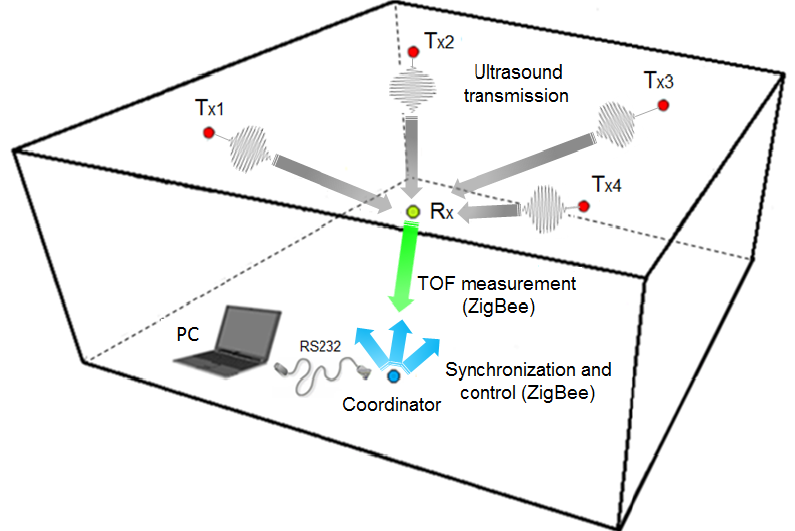
Figure 4. The typical configuration of the TELIAMADE system. A coordinator node is connected to a PC through which all other nodes of the network are managed. A set of fixed nodes work as ultrasonic transmitters (Tx) and are placed on known positions (typically at the ceiling). The mobile node operates as ultrasonic receiver. Its position is determined by applying multilateration using the estimated distances to the transmitter